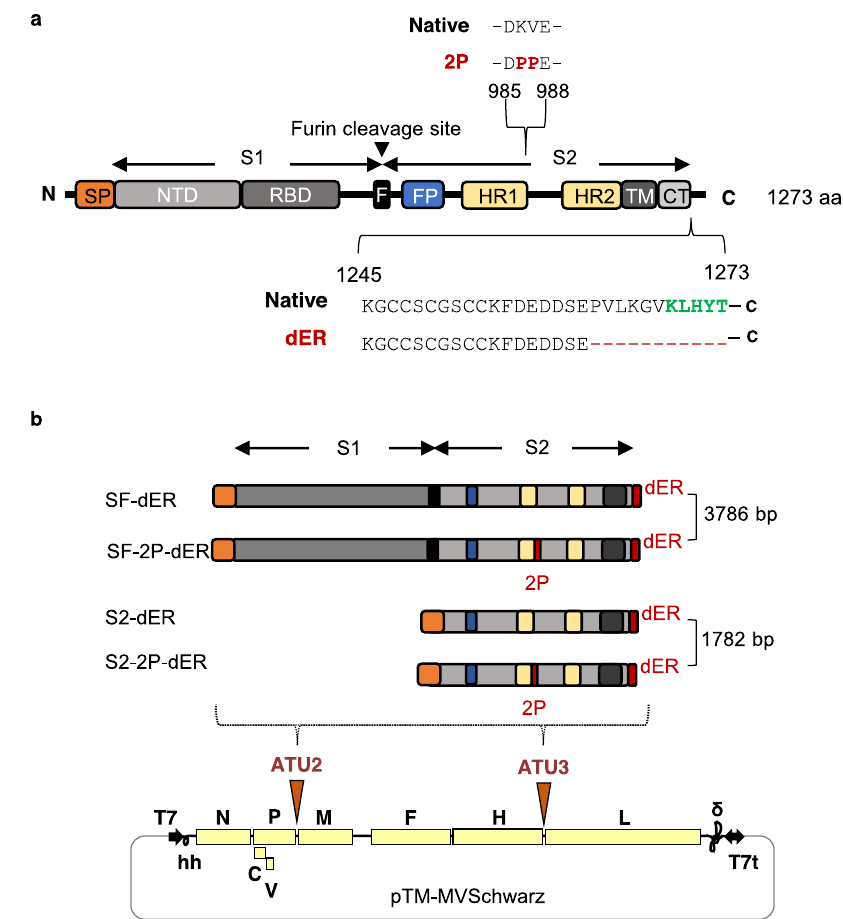
Fig. 1 Schematic of the native S protein of SARS-CoV-2 and S gene constructs. a The native S protein is 1273 amino acids (aa) in length. The protein contains 2 subunits, S1 and S2, generated by cleavage at the furin cleavage site (F). S1 contains the signal peptide (SP), N-terminal domain (NTD) and receptor-binding domain (RBD). S2 contains the fusion peptide (FP), heptad repeats 1 (HR1) and 2 (HR2), transmembrane domain (TM), and cytoplasmic tail (CT). The 2P indicates the two mutated prolines, K986P and V987P. The green letters indicate the endoplasmic reticulum retrieval signal (ERRS) motif, KxHxx, in the CT. dER indicates constructs carrying a deletion of the 11 C-terminal amino acids from the CT. b The native S gene of SARS-CoV-2 with notable domains indicated in color boxes relative to the S gene constructs cloned into the MV vector. 2P and dER modi fi cations indicated by the red boxes. All S constructs were cloned into either the second (ATU2) or third (ATU3) additional transcription units of pTM-MVSchwarz (MV Schwarz), the MV vector plasmid. The MV genome comprises the nucleoprotein (N), phosphoprotein (P), V and C accessory proteins, matrix (M), fusion (F), hemagglutinin (H) and polymerase (L) genes. Plasmid elements include the T7 RNA polymerase promoter (T7), hammerhead ribozyme (hh), hepatitis delta virus ribozyme ( ∂ ), and T7 RNA polymerase terminator